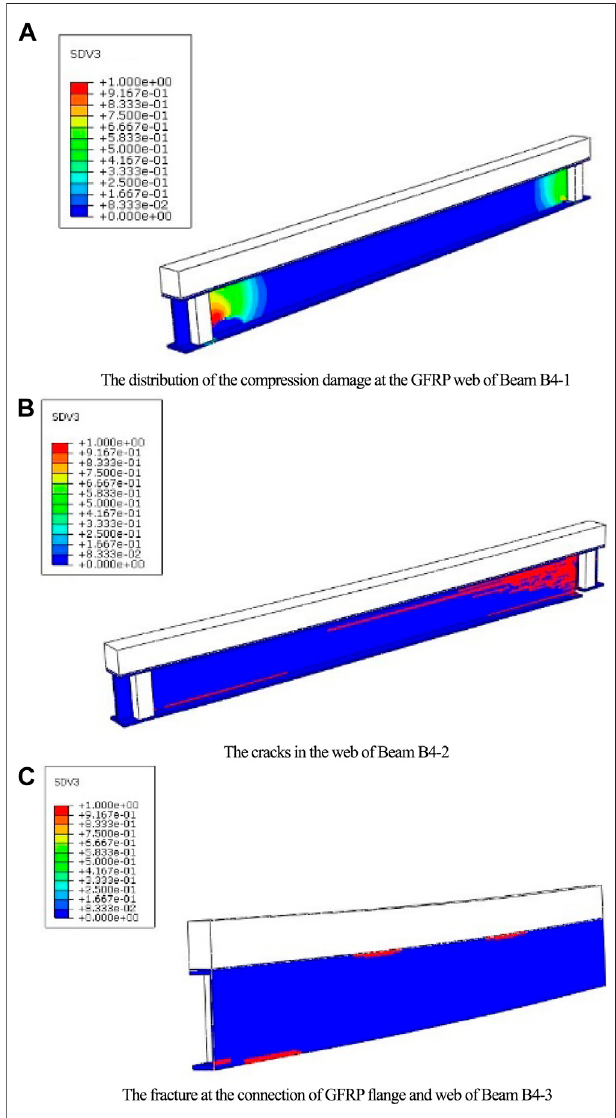
FIGURE 12 | In fl uence of the shear-span ratio on the failure mode of Beam C, where SDV3 is a tensile damage factor of the GFRP matrix. (A) Distribution of the compression damage at the GFRP web of Beam B4-1. (B) Cracks in the web of Beam B4-2. (C) Fracture at the connection of the GFRP fl ange and web of Beam